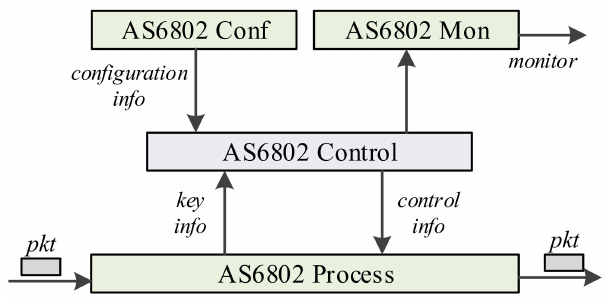
Figure 7. The implementation of the AS6802 IP core.